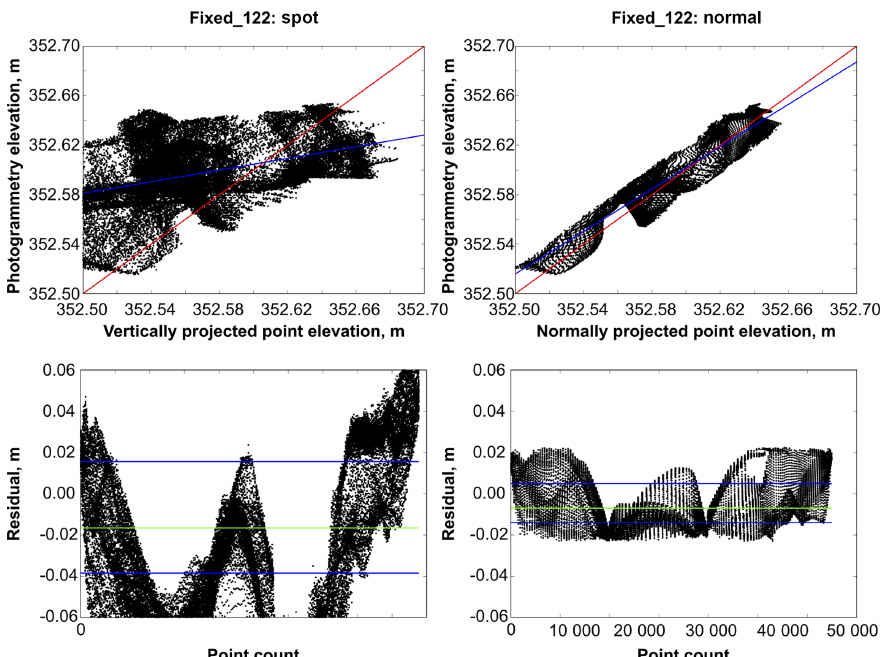
Figure 9. At 122m of flight altitude, fixed-wing spot elevation comparison (left column) and normal to plane comparison (right column) of photogrammetry and lidar point cloud data with a fitted line through the elevations (blue; spot) and the 1 : 1 line (red; spot); green is the mean residual and the blue lines are the 25th and 75th percentiles.